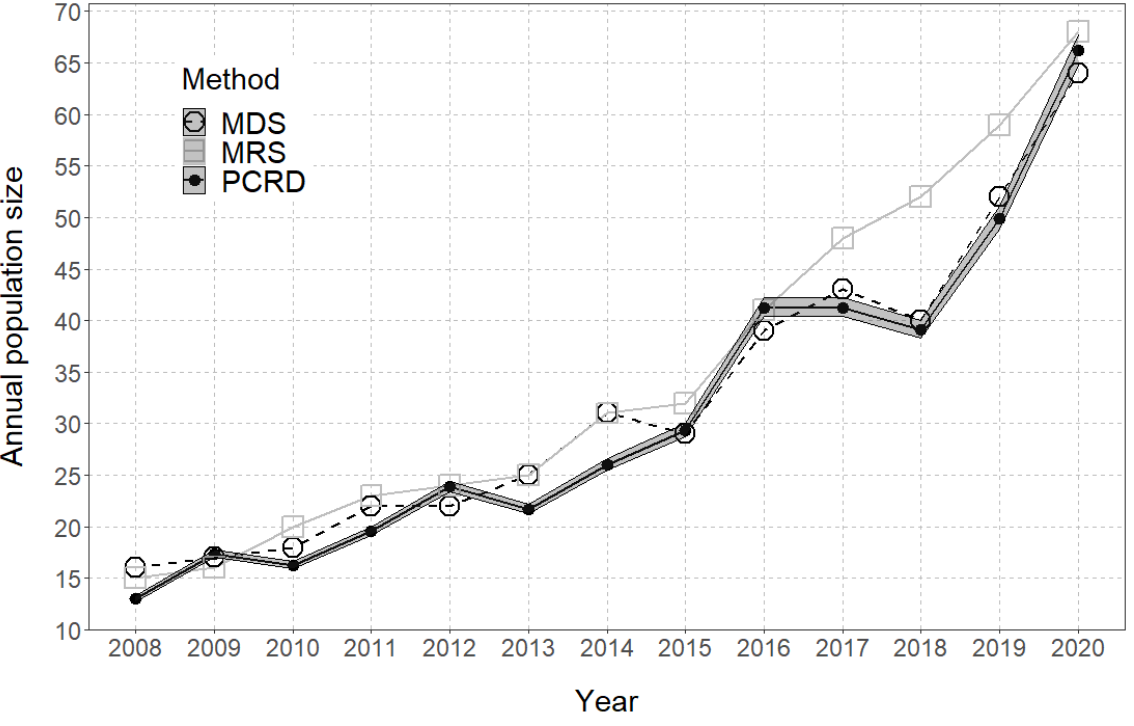
Figure 2: Variation in the annual population size of the Pyrenean brown bear from 2008 to 2020, estimated from Bayesian Pollock’s robust design capture-recapture approach (PCRD, black full circles and black full line, with the associated 95% credible interval in grey), compared to the Minimum Retained population Size (MRS, grey open squares and grey full line) and Minimum Detected population Size (MDS, black open circles and black dashed line)